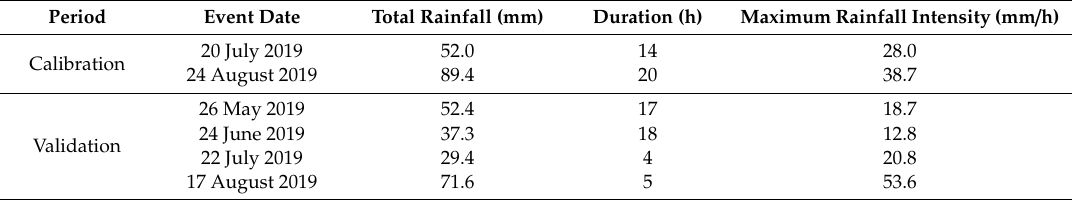
Table 3. Characteristics of the rainfall events simulated during the calibration and